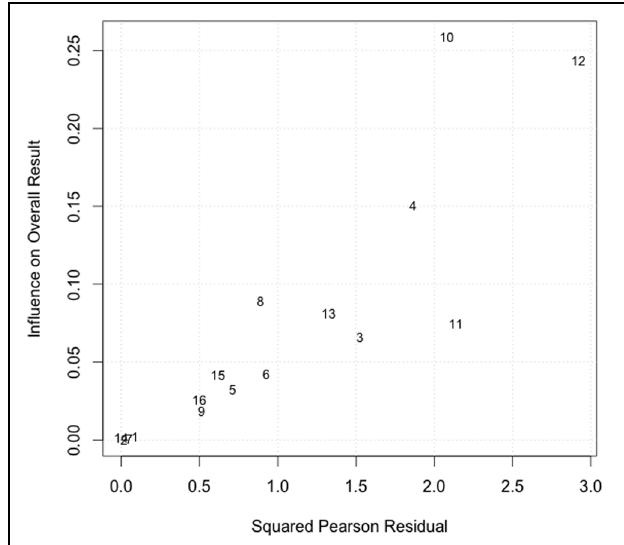
FIGURE 3 | Baujat plot to identify studies contributing to heterogeneity. Each study is represented by a study id number. Studies located in the top right quadrant have both a greater influence on the overall result and contribute most to study heterogeneity.